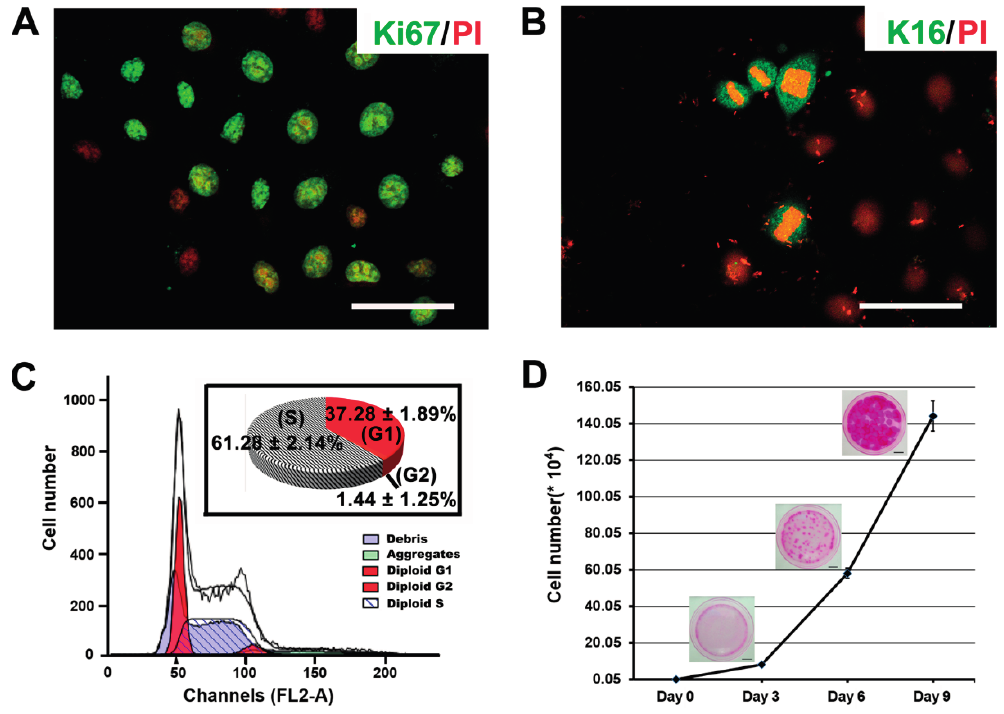
Figure 3. ( A ) Ki67 immunofluorescence staining in P6 ovine bulge-derived keratinocytes three days after passaging; ( B ) K16 immunofluorescence staining in P6 ovine bulge-derived keratinocytes. Note that K16 is present in cells during division, associated with pre-separating, separating and newly-separated chromosomes; ( C ) The cell cycle distribution of the ovine bulge-derived keratinocytes; ( D ) A growth curving showing the proliferation of 500 ovine bulge-derived keratinocytes during nine days of culture, along with the morphology of cell colonies at different time points. For ( A , B ), the scale bar is 50 μ m; for ( D ), the scale bar is 1